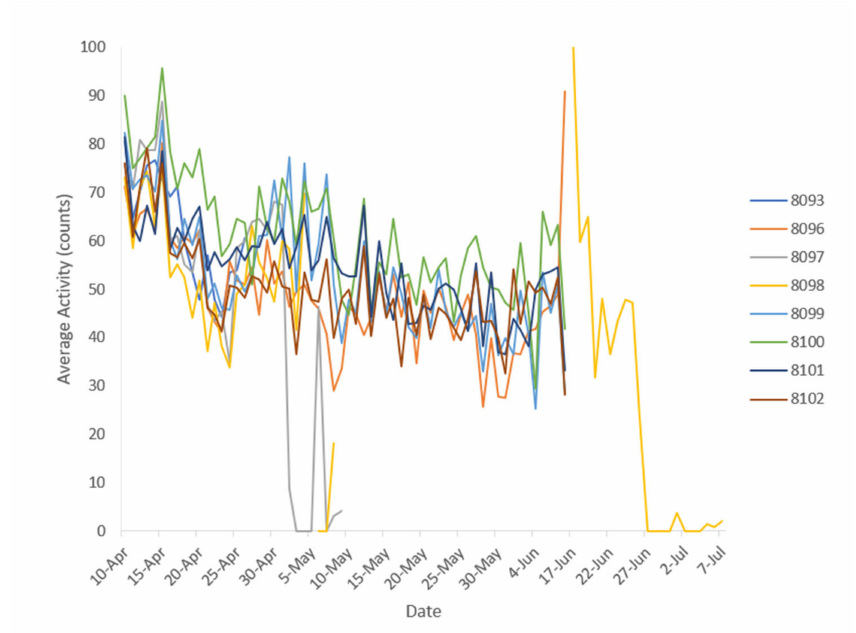
Figure 6. Average activity data from Vectronic vaginal implant tags (VIT) in Trial 2. All VIT retrieved in Trial 2 are